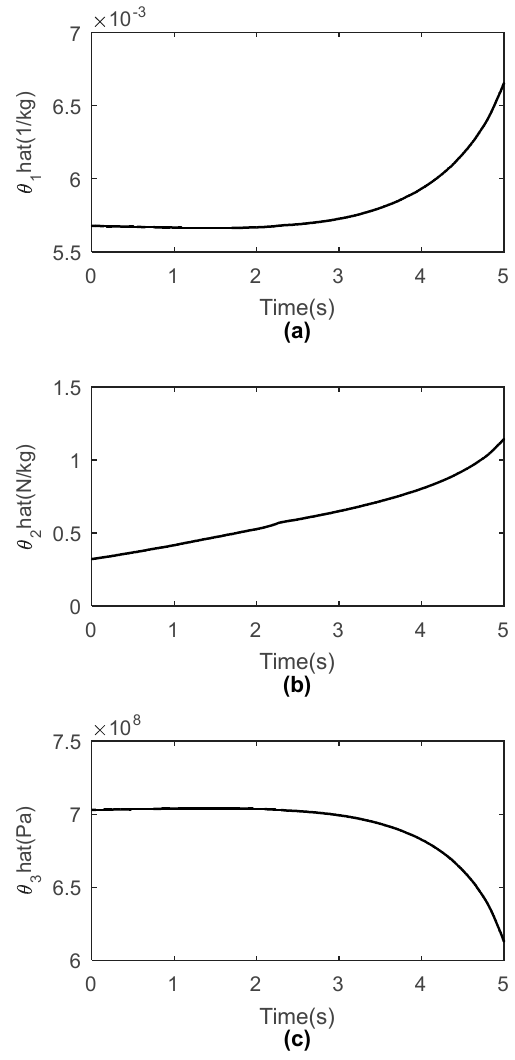
Figure 8. Parameter estimations of ARC: ( a ) estimation of θ 1 ; ( b ) estimation of θ 2 ; ( c ) estimation of θ 3 .